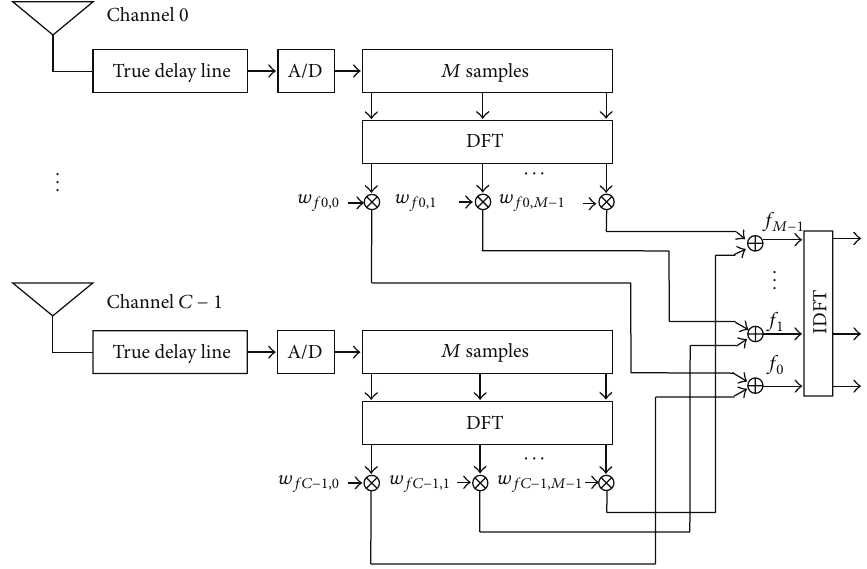
Figure 2: WB nulling in the frequency